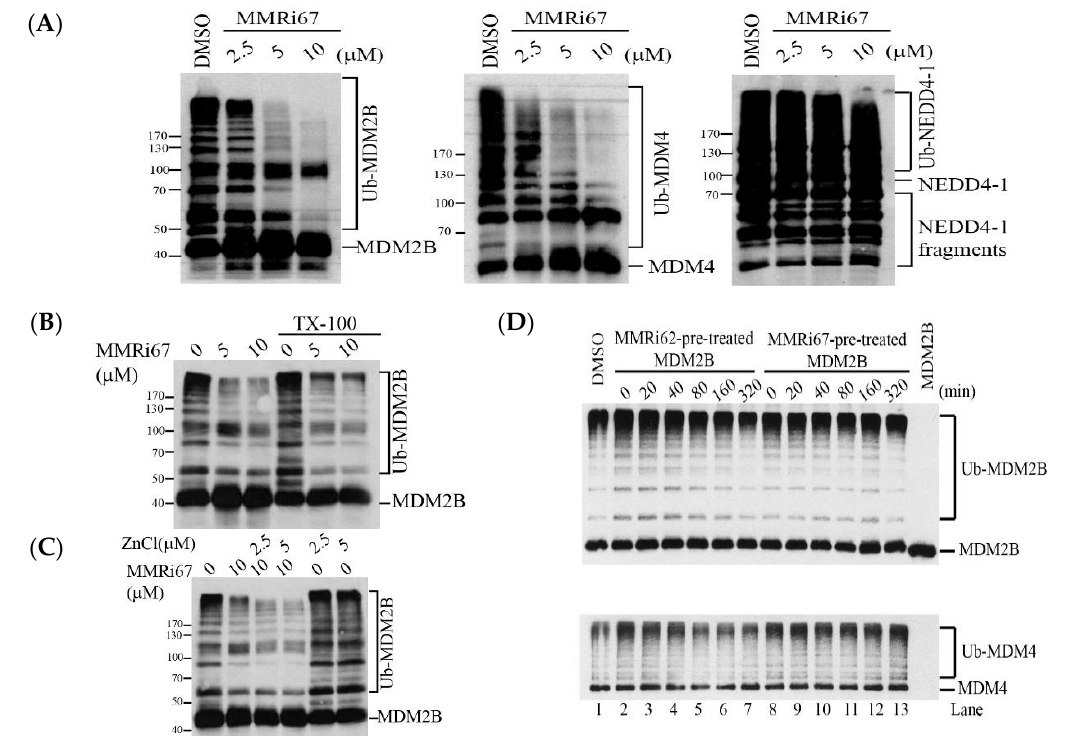
Figure 2. MMRi67 is a small molecule inhibitor of MDM2-MDM4 E3 ligase activity. ( A ) MMRi67 inhibits the ubiquitination of MDM2B (left) and MDM4 (middle) by MDM2B-MDM4 E3 complex but not NEDD4-1 (right) in the in vitro E3 ligase assays. WB analysis of MDM4, MDM2B, and NEDD4-1 using specific antibodies after in vitro ubiquitination reaction in the presence of solvents or indicated concentrations of MMRi67 . The smearing bands of ubiquitinated MDM4 (Ub-MDM4), ubiquitinated MDM2B (Ub-MDM2B), and ubiquitinated NEDD4-1 (Ub-NEDD4-1) are indicated. ( B ) The E3 ligase inhibitory activity of MMRi67 is not abolished by the presence of 0.01% Triton X-100. Same procedure as in ( A ) except the ubiquitination reaction was performed in the presence of 0.01% Triton X-100. Only MDM2B data are shown. ( C ) The E3 ligase inhibitory activity of MMRi67 is not abolished by the presence of increasing concentrations of Zn to neutralize the potential chelating capability of MMRi67 . The same procedure as in ( A ) except for the presence of indicated concentrations of Zn. Only MDM2B data are shown. ( D ) Preincubation of MDM2B proteins with MMRi67 does not abolish MDM2B E3 ligase activity. Same procedure as in ( A ) except MDM2B was preincubated with either 10 μM MMRi62 or MMRi67 for the indicated min before 10-times dilution and was used for ubiquitination reaction; the preincubation did not affect the ubiquitination of MDM2B or MDM4 by the MDM2B-MDM4 E3 complex.